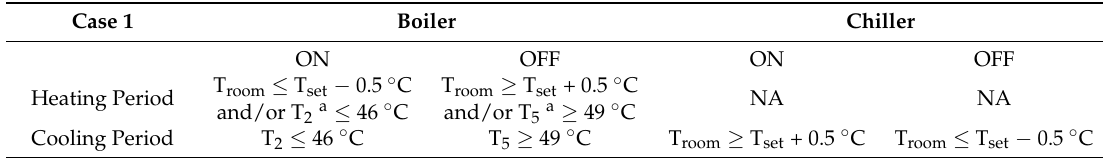
Table 3. Control strategies for boiler-chiller system (reference